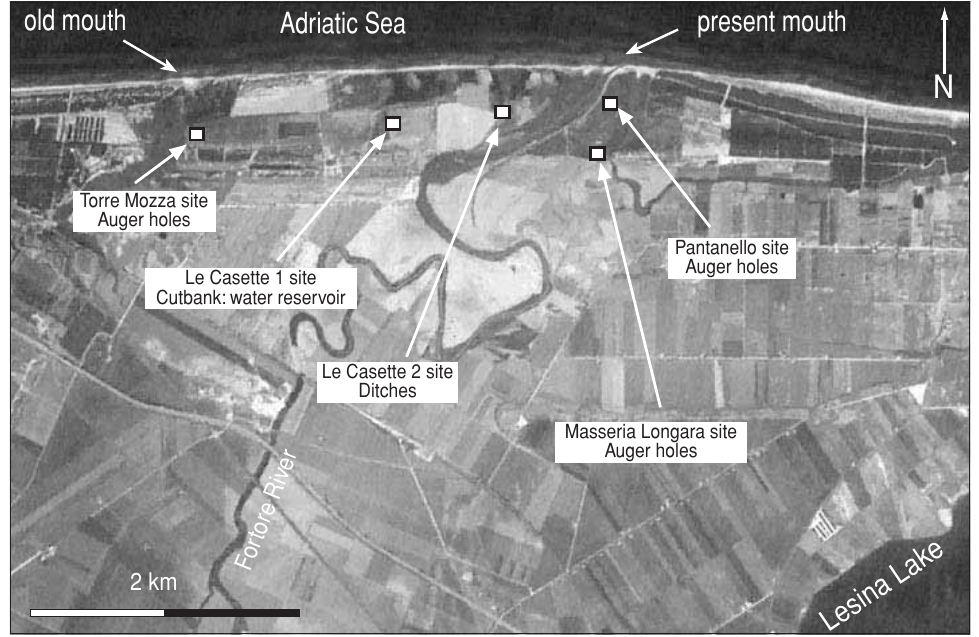
Fig. 4. Spot image (DOI-10M - National Imagery and Mapping Agency: contains data (C) CNES/SPOT image 1992-1994 copyright) of the Fortore mouth area with location of the investigated